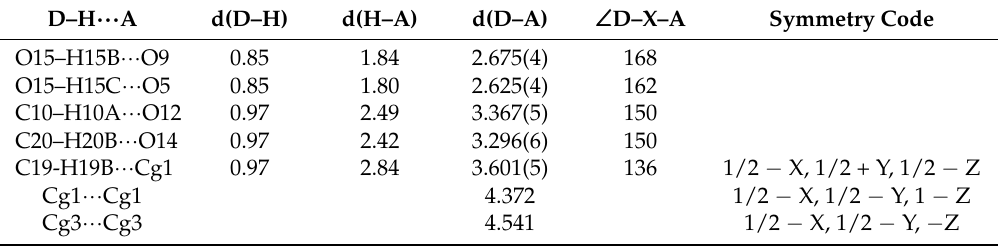
Figure 6. Hirshfeld surfaces mapped with ( a ) d norm and ( b ) d i of the Zn II coordination compound. The surfaces are depicted as transparent to allow visualization of the molecule structure.